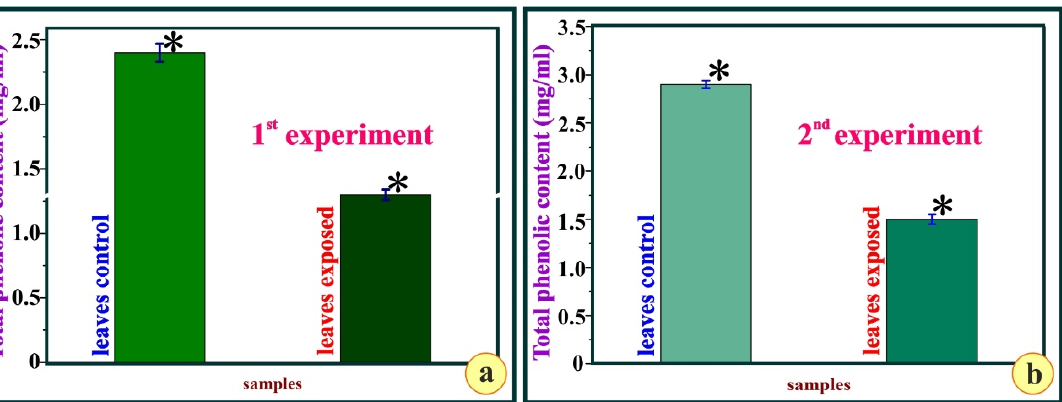
Figure 6. Cross-sections of a leaf from ( a ) a control plants and ( b ) an exposed plant. Paradermal Figure 7. The total phenolic content of ( a ) the leaves of the control (left) and the exposed (right) sections from a leaf of ( c ) a control plant and ( d ) an exposed plant. pp = Palisade parenchyma, sp = plants from the first experiment and ( b ) the leaves of the control (left) and the exposed (right) spongy parenchyma. Red arrow points at a stoma on the adaxial surface, yellow arrows point at plants from the second experiment. Differences were considered as statistically significant if p > idioblasts with crystals. (All scale bars are 100 μ m). 0.05. Asterisks (*) indicate statistically significant differences.